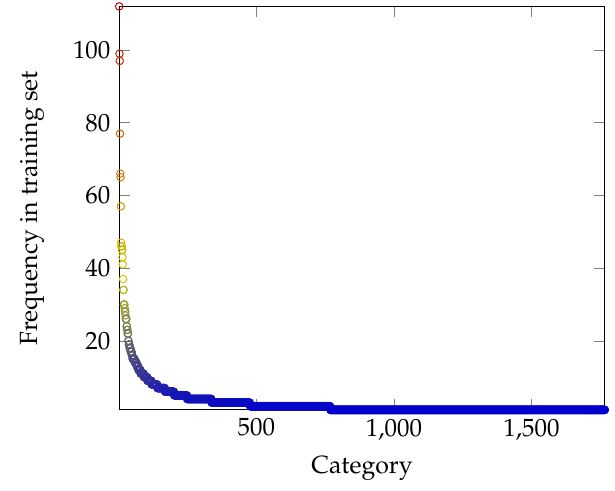
Figure 4. Category frequencies of CodiEsp training